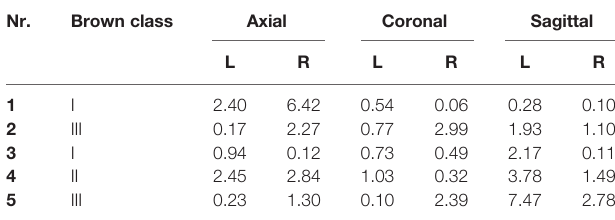
TABLE 3 | Angle deviations in degrees (°) between the preoperative virtual plan and the postoperative result. Nr.